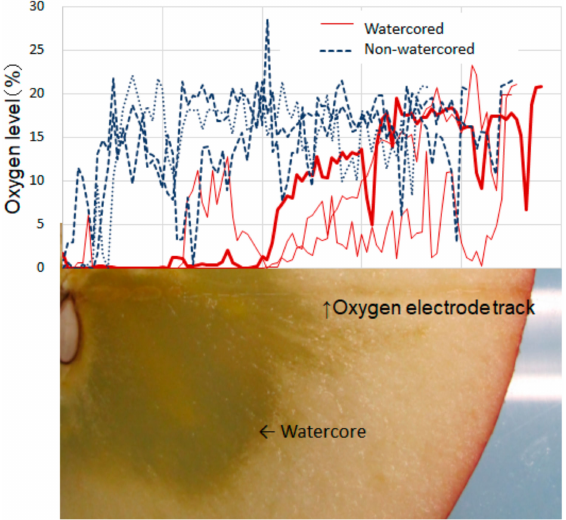
Figure 3. Oxygen distribution related to watercore of ‘Fuji’ apple. Three fruits were measured for each class. Thick red line corresponds to the photograph. Reproduced with permission from Tanaka et al.